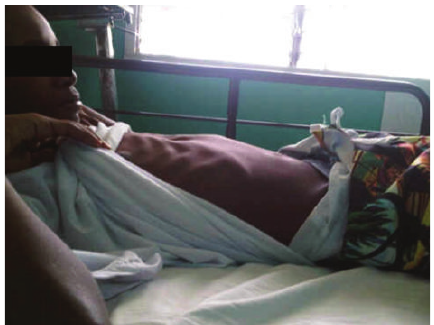
Figure 6: Immediate abdominal decompression (a) after 3700 mL of turbid pancreatic fluid was drained from the cyst (b).